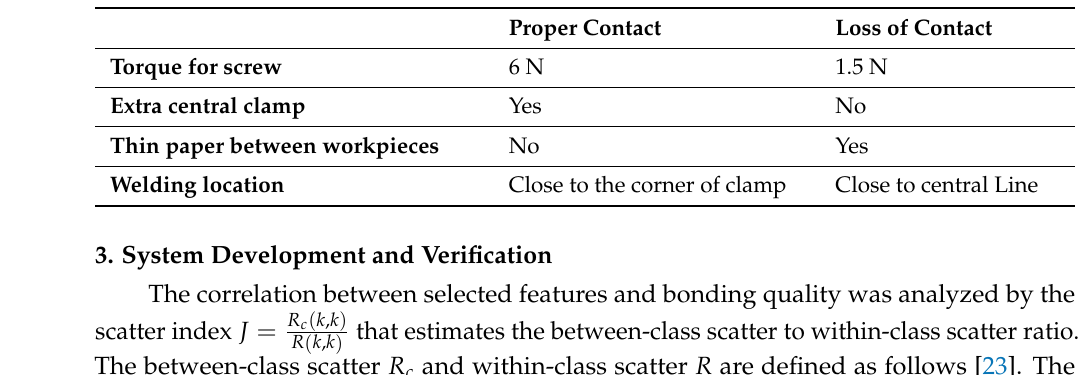
Figure 3. Setup for welding with ( a ) proper contact and ( b ) loss of contact. Table 2. Parameter settings for the generation of proper contact and loss of contact